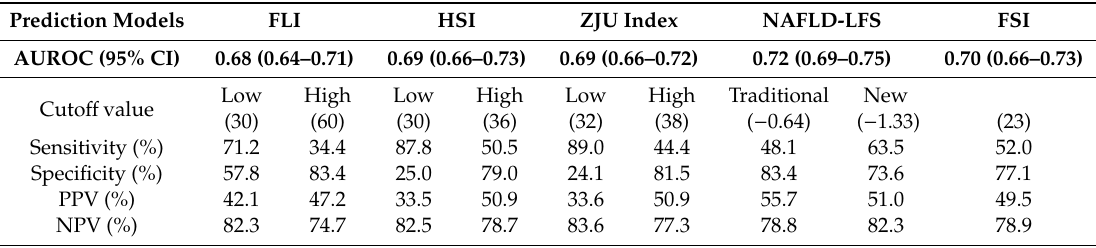
Table 2. Diagnostic performance of prediction models for fatty liver compared to magnetic resonance imaging